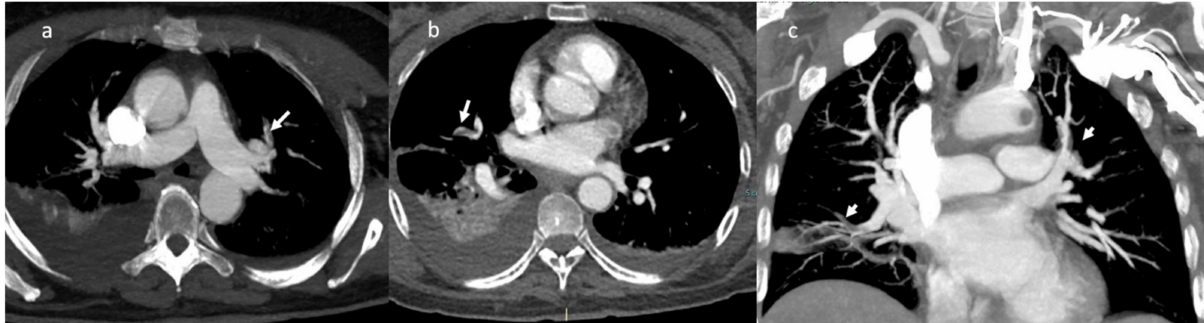
Figure 4. CT-angiography: presence of multiple contrast filling defects involving the left upper lobe segmental branches ( a ), the right segmental artery ( b ); MPR coronal plane in ( c ).